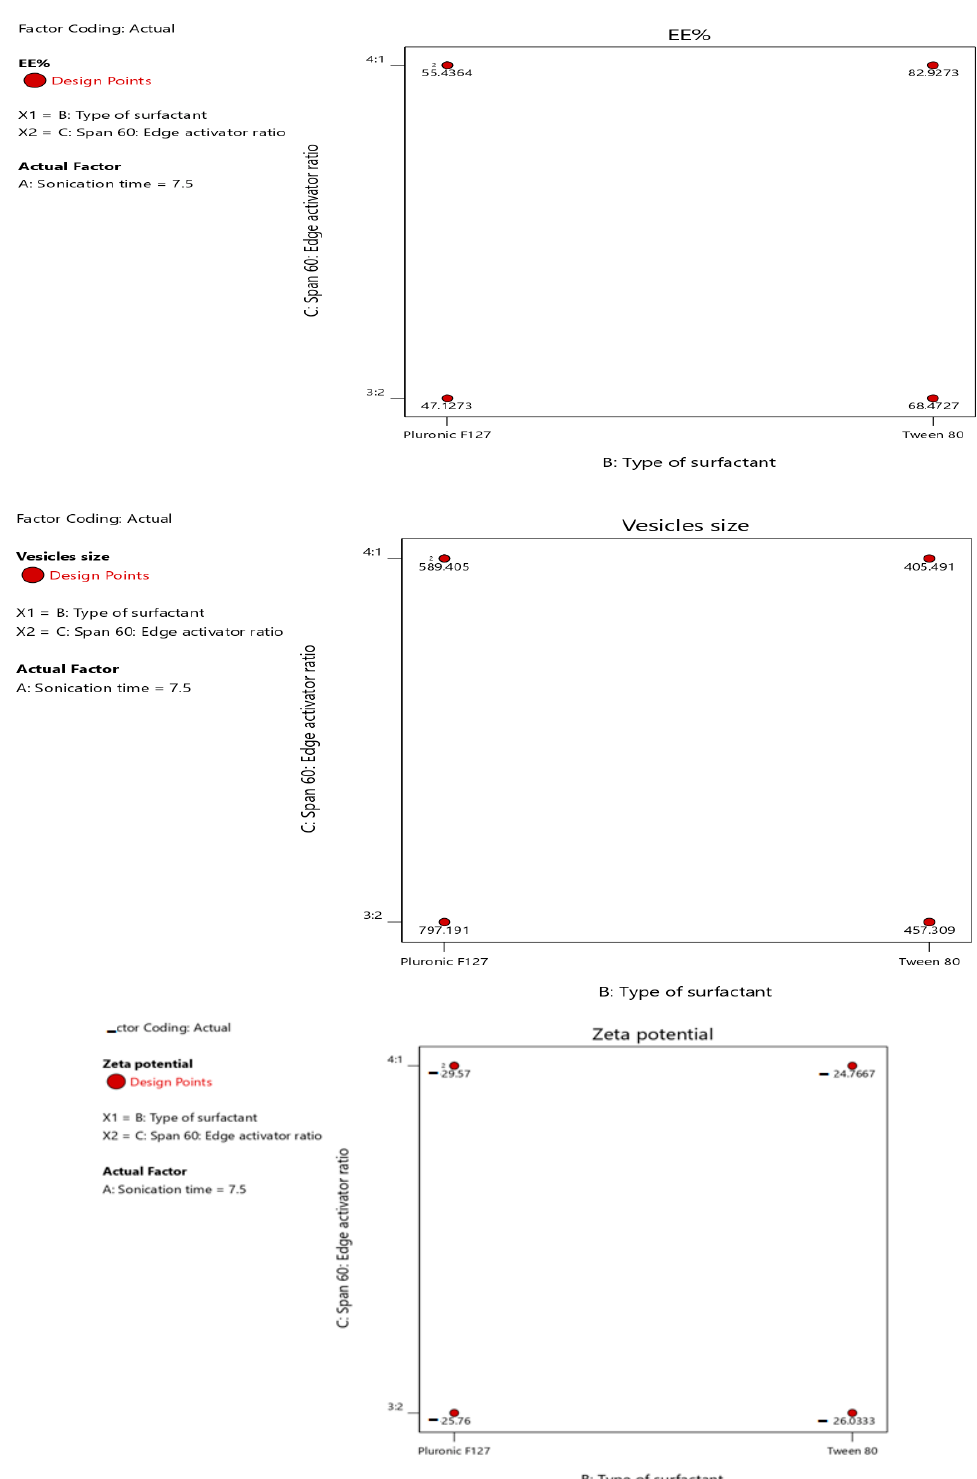
Figure 2. Contour plot of different responses.